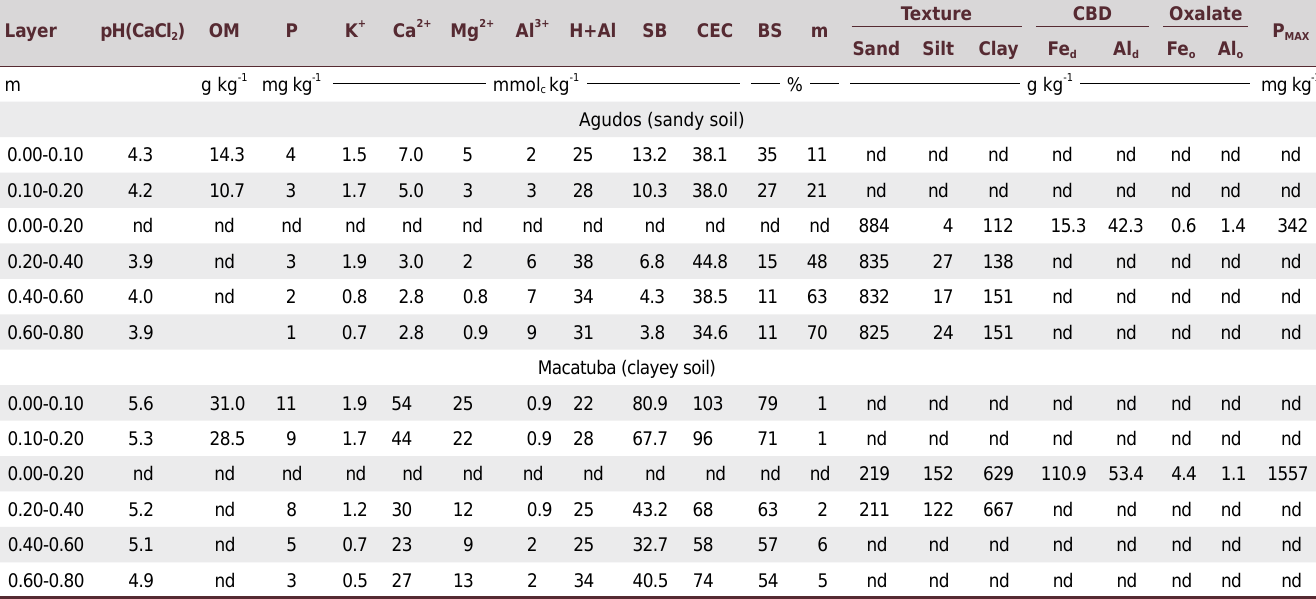
Table 1. Soil physical, mineralogical, and chemical properties before sugarcane trial establishment in Agudos and Macatuba locations Layer pH(CaCl 2 ) OM